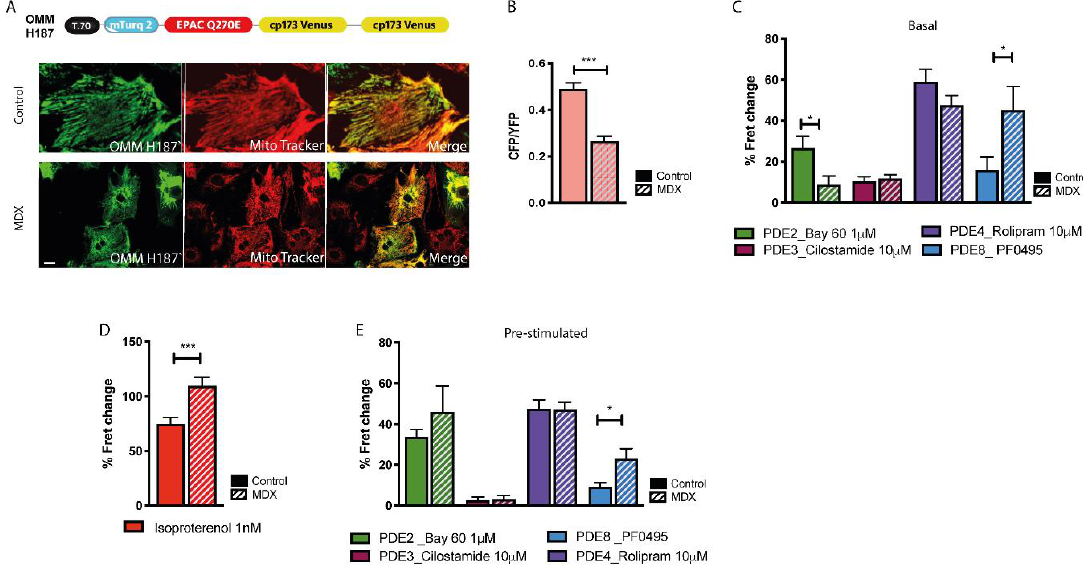
Figure 6. Comparison of cAMP signals at the OMM of NVM from control and mdx mice. ( A ) Top: schematic representation of the OMM-targeted cAMP FRET reporter OMM-H187. Bottom: left, representative images of control and mdx NVM expressing OMM-H187. Co-staining with the mitochondria specific dye mitotracker is shown in the central panels and the overlay is shown on the right. ( B ) Mean relative values for CFP to YFP fluorescence intensity ratio recorded in unstimulated NVM from control and mdx mice expressing OMM-H187. n = 4. ( C ) Mean FRET change recorded in NVM expressing OMM-H187 on application of family-selective cAMP-PDE inhibitors as indicated. n = 4. ( D ) Mean FRET change recorded in NVM from control or mdx mice expressing OMM-H187 on application of ISO 1 nM. n = 4. ( E ) Mean FRET change recorded in NVM expressing OMM-H187 on application of family-selective cAMP-PDE inhibitors, as indicated, in cells pre-treated with 1 nM ISO. n = 4. For all data, mean ± SEM are shown. * = 0.01 ≤ p ≤ 0.05, *** = p < 0.001. Size bar: 10 µm.